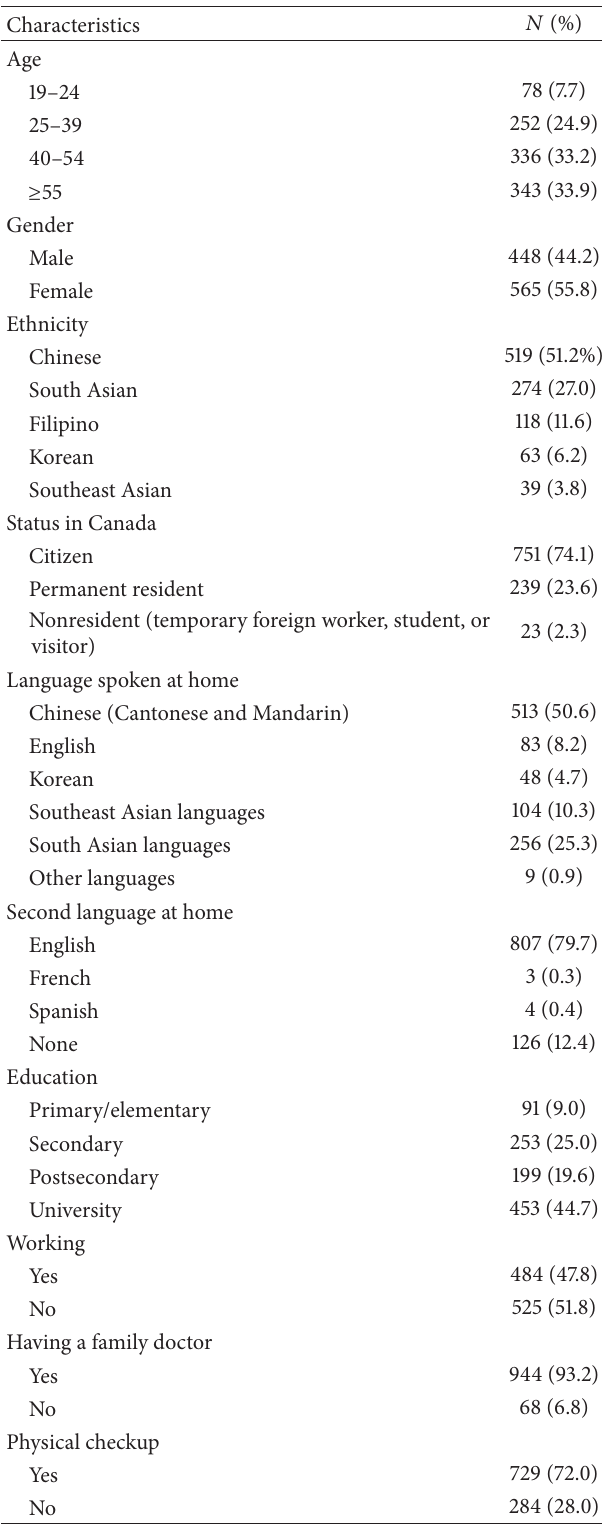
Table 1: Baseline characteristics of survey